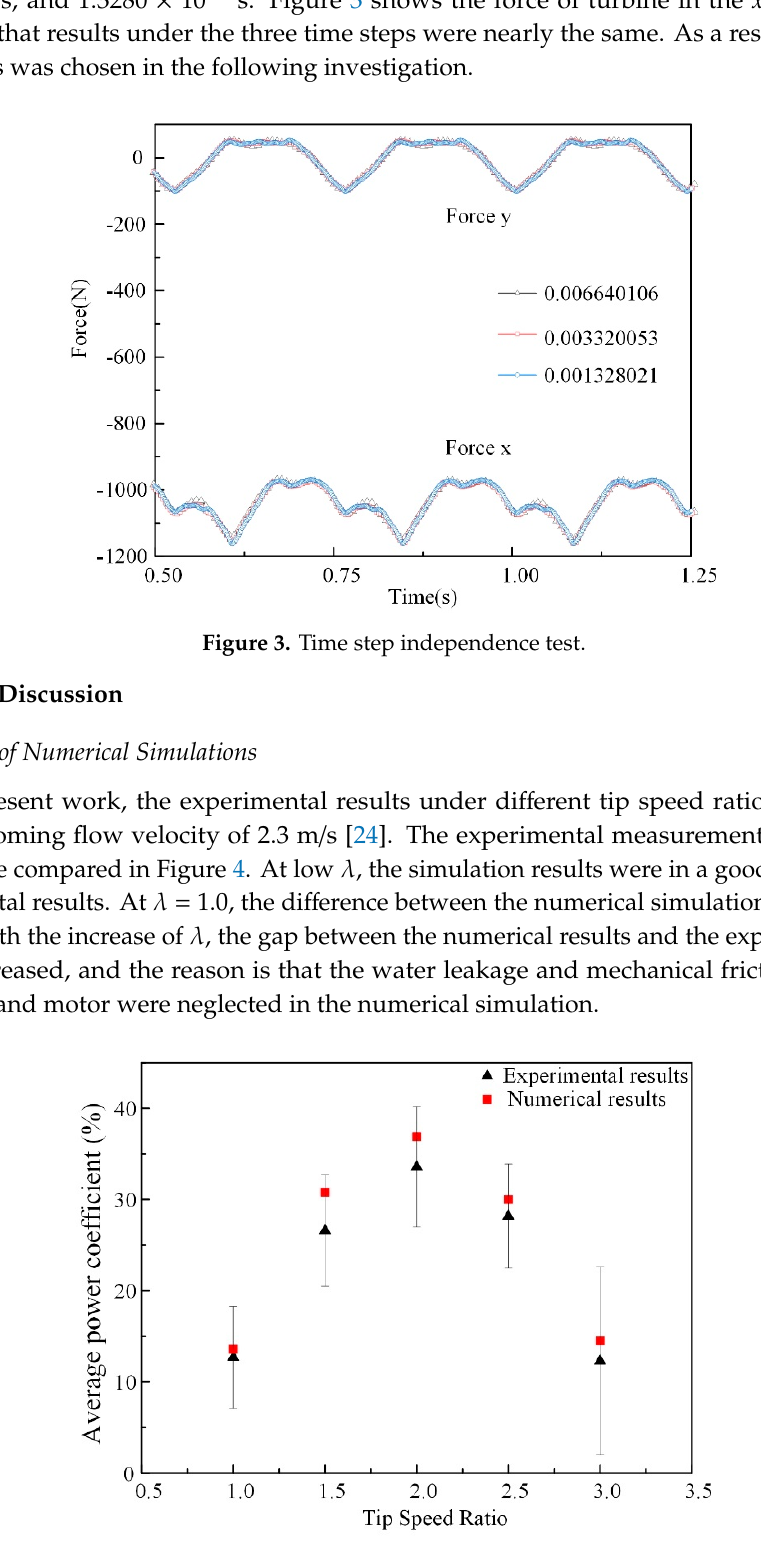
Figure 4. Comparison of the average power coefficient: experiments [24] and numerical simulation.